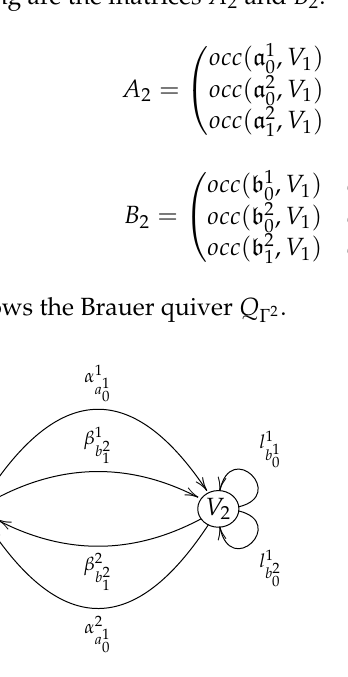
Figure 4. Brauer quiver associated with a Catalan–Brauer configuration algebra Λ Γ 2